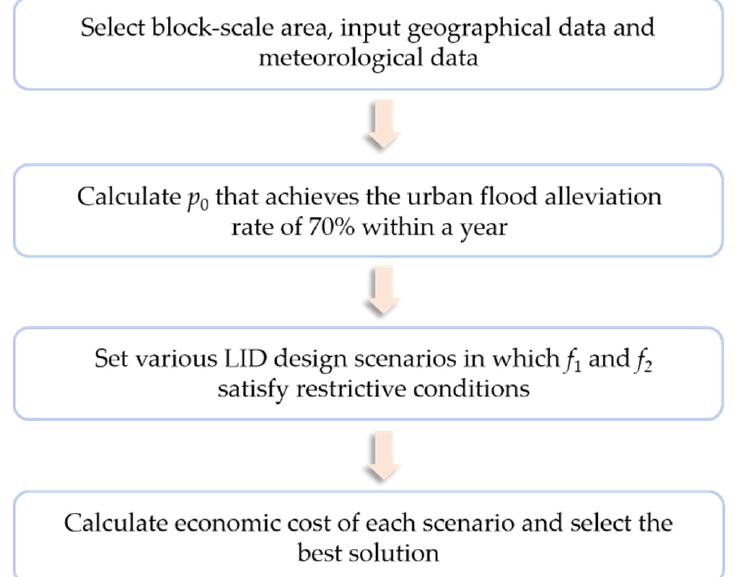
Figure 2. Flow chart of the multiobjective optimization model.